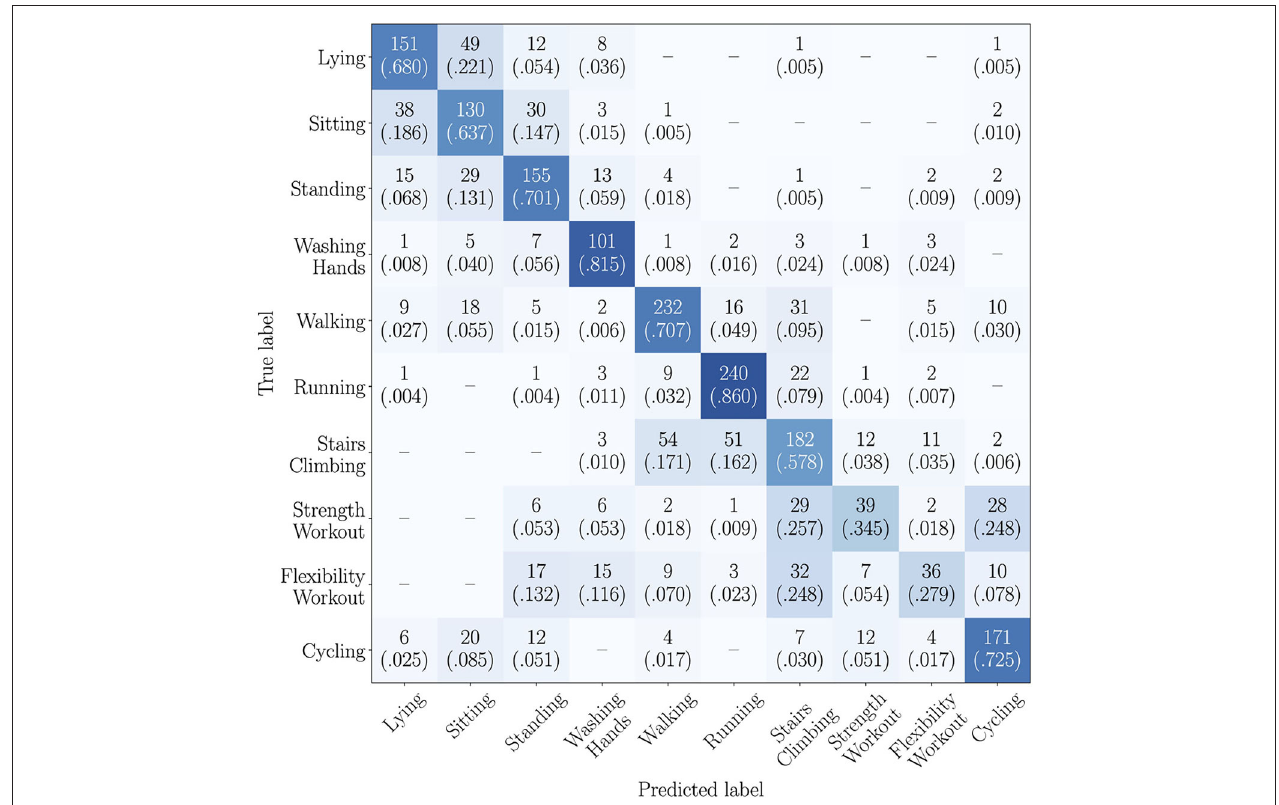
FIGURE 5 | Confusion matrix computed from the predictions inferred using the CNN-based approach exploiting f steps ⊗ hr ⊗ xyz as input features. Each cell contains the absolute and the relative number of samples of the actual class (row) classified into each possible activity of the recognition set (column). The relative information is also depicted using a color-scale: dark colors illustrate high percentages, while light colors, low percentages. Empty cells indicate no samples from the actual activity are classified into the corresponding